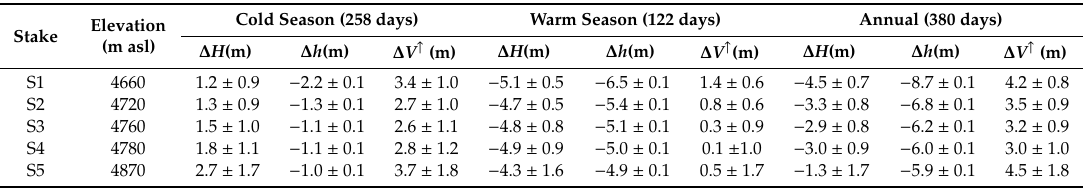
Table 2. In-situ measured surface lowering ( ∆ h), UAV-SfM orthomosaic-derived surface elevation ↑ change ( ∆ H ) and emergence velocity ( ∆ V ) near the five stakes on the ablation zone of Parlung No. 4 Glacier over seasonal and annual